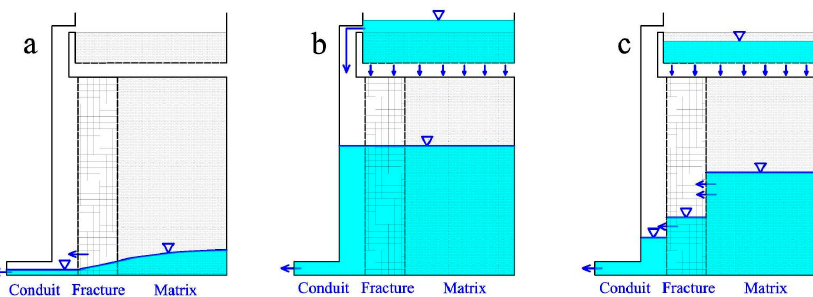
Figure 13. Stages of water charging and releasing process under long-time heavy rainfall condition. ( a ) No rainfall for a long time; ( b ) Recharge in long-time heavy rain; ( c ) Recession after long-time heavy rain.